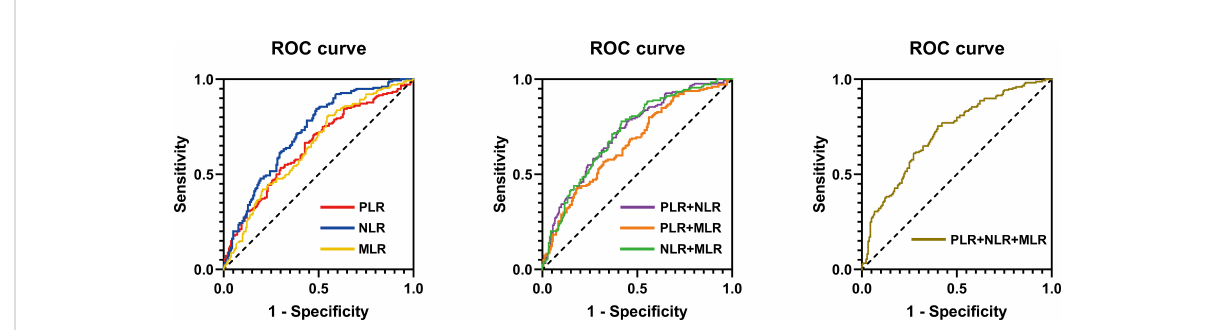
FIGURE 4 ROC curve for MLR, NLR, PLR, and combined diagnosis for predicting arterial